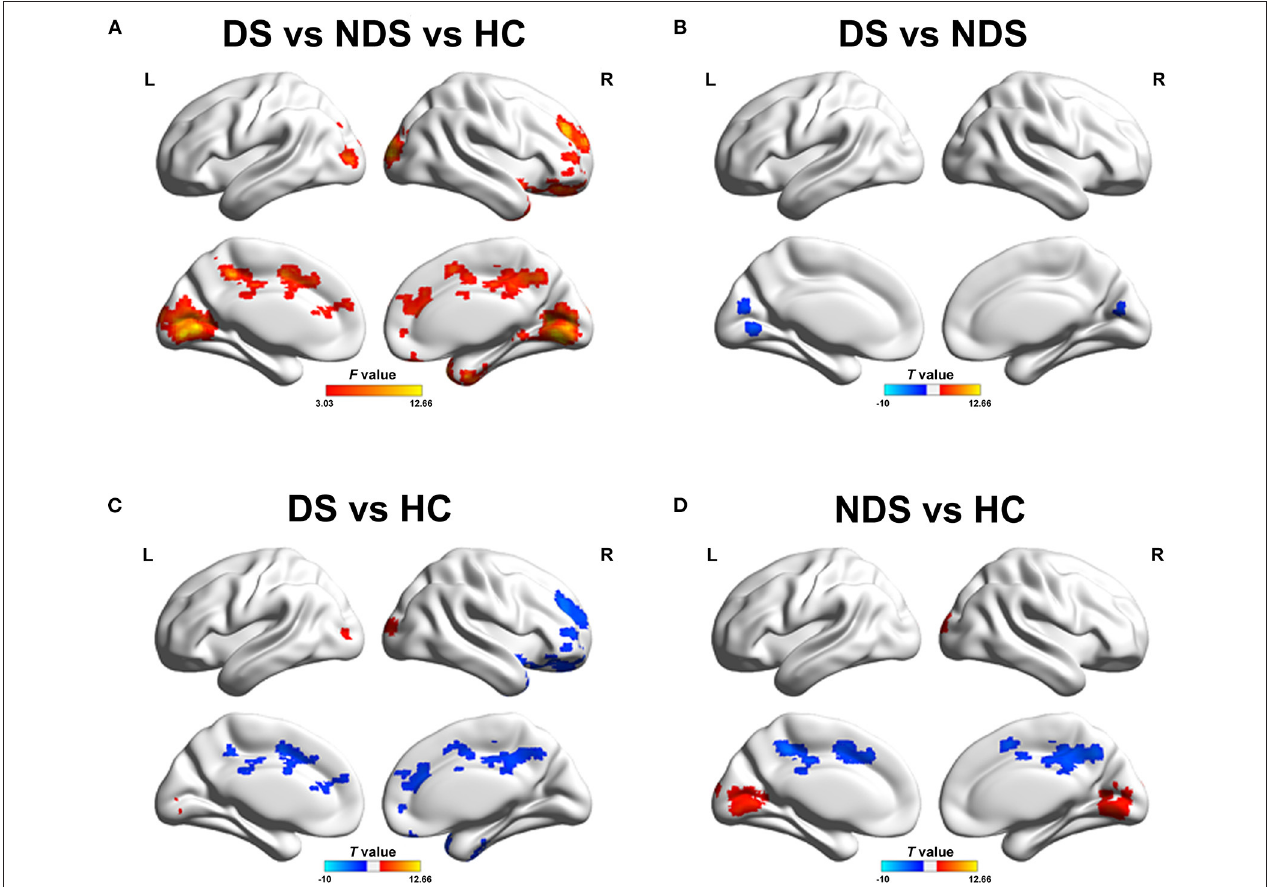
FIGURE 1 | (A) Group comparisons of FC in left NAcc network among DS, NDS, and HC. The red regions represent significantly different regions. (B) Group analyses of the FC in left NAcc network between DS and NDS. The blue areas denote the regions where DS had lower FC compared to NDS. (C,D) Group analyses of the FC in left NAcc network between patients and HC groups. The blue areas indicate the regions where patients had lower FC compared to HC; the red areas signify the regions where patients had greater FC compared to HC. The significant threshold was set at p ≤ 0.05 after 3dClustSim corrected (voxel p ≤ 0.05, cluster size ≥ 200). FC, Functional Connectivity; NAcc, Nucleus accumbens; DS, Deficit Schizophrenia; NDS, Non-deficit Schizophrenia; HC, Healthy Controls.